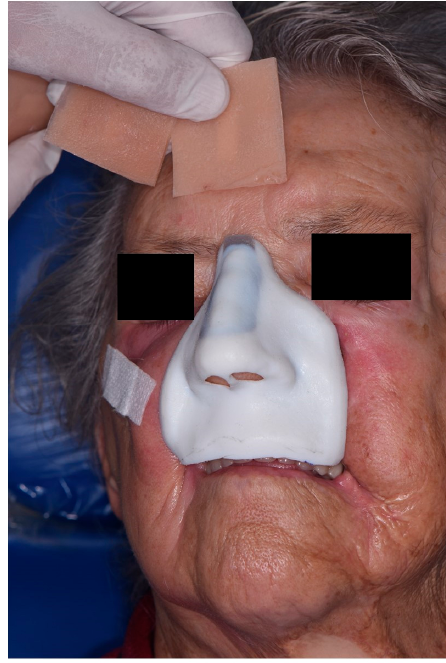
Figure 9. Color matching and try-in of the resin prototype.